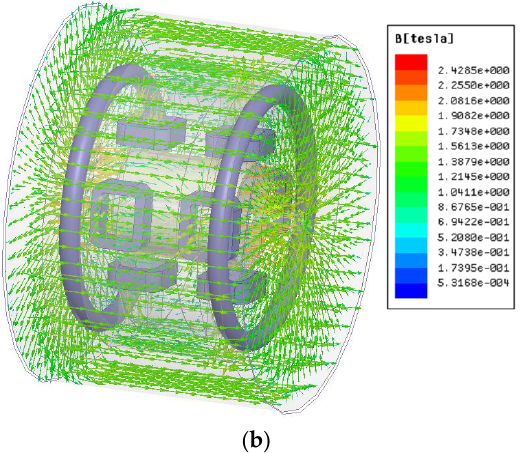
Figure 9. Flux density distribution at rated current. ( a ) Flux density distribution of one set of radial control windings; ( b ) flux density distribution of one set of axial control windings.